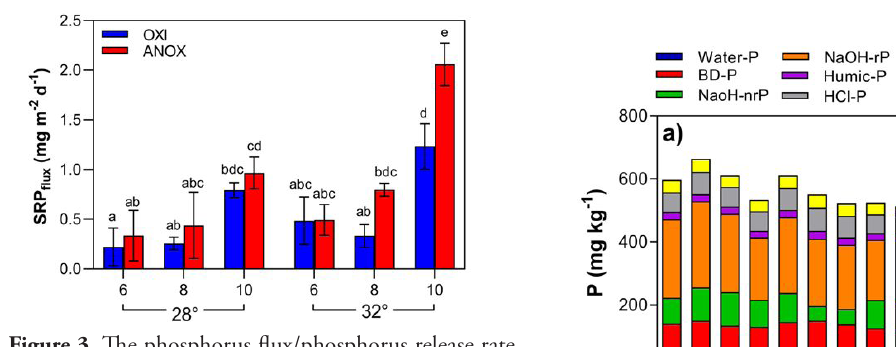
Figure 3. The phosphorus flux/phosphorus release rate (P mg m -2 d -1 ) from the sediment to the water of the flux, Boqueirão reservoir after the 21 days of the experiment for different variations of pH (6, 8 and 10), oxygen (oxic and anoxic conditions) and temperature (28° C and 32° C). Means followed by the same letter do not differ from each other by the Tukey’s test for p ≤ 0.05. OXI = oxic treatment (dissolved oxygen > 5 mg L -1 ), ANOX = anoxic treatment (dissolved oxygen < 1 mg L -1 ).